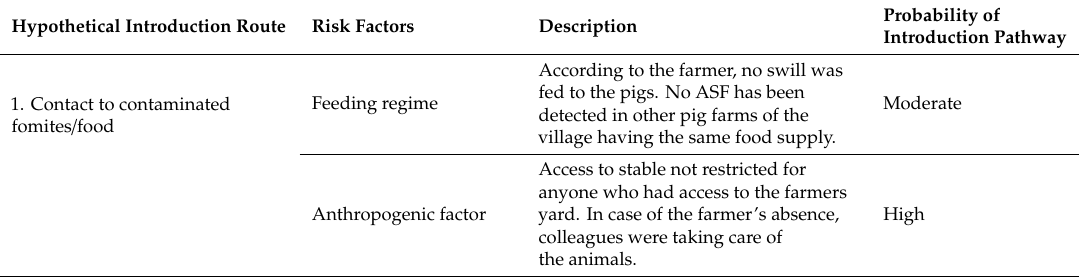
Table 2. Hypothetical introduction routes and their estimated